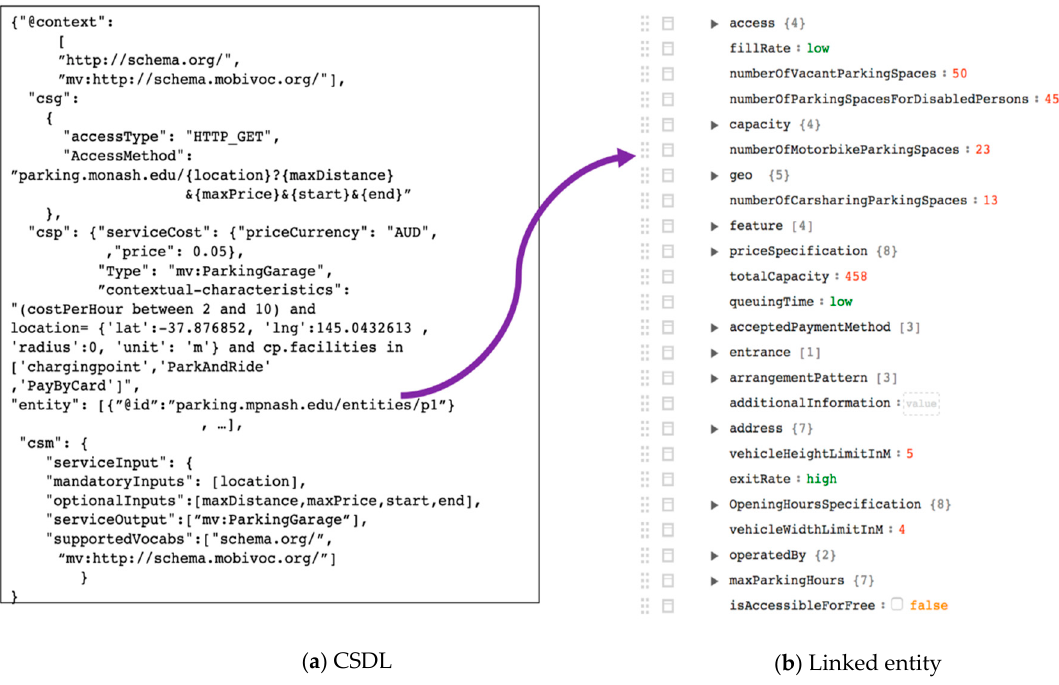
Figure 6. An example of service description in CSDL.